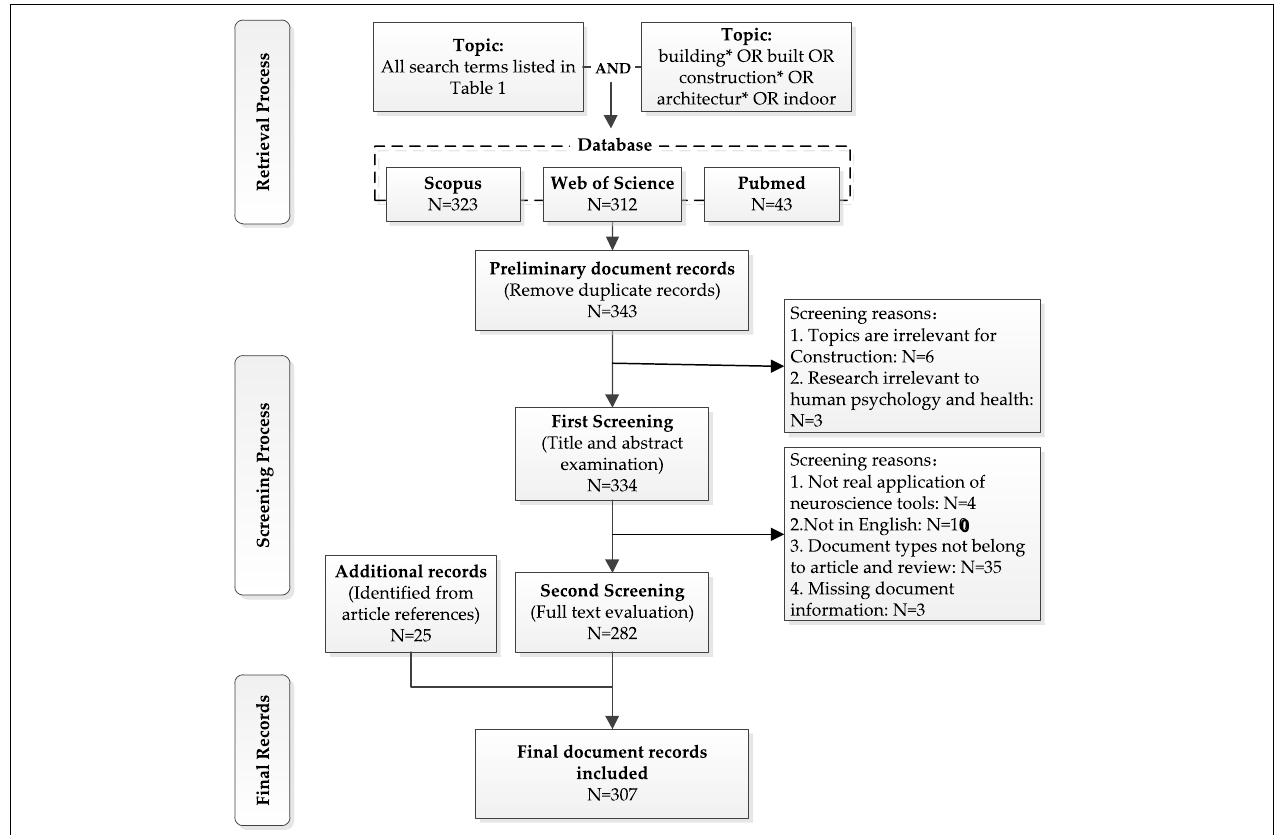
FIGURE 1 | Flowchart describing the procedure for document retrieval and